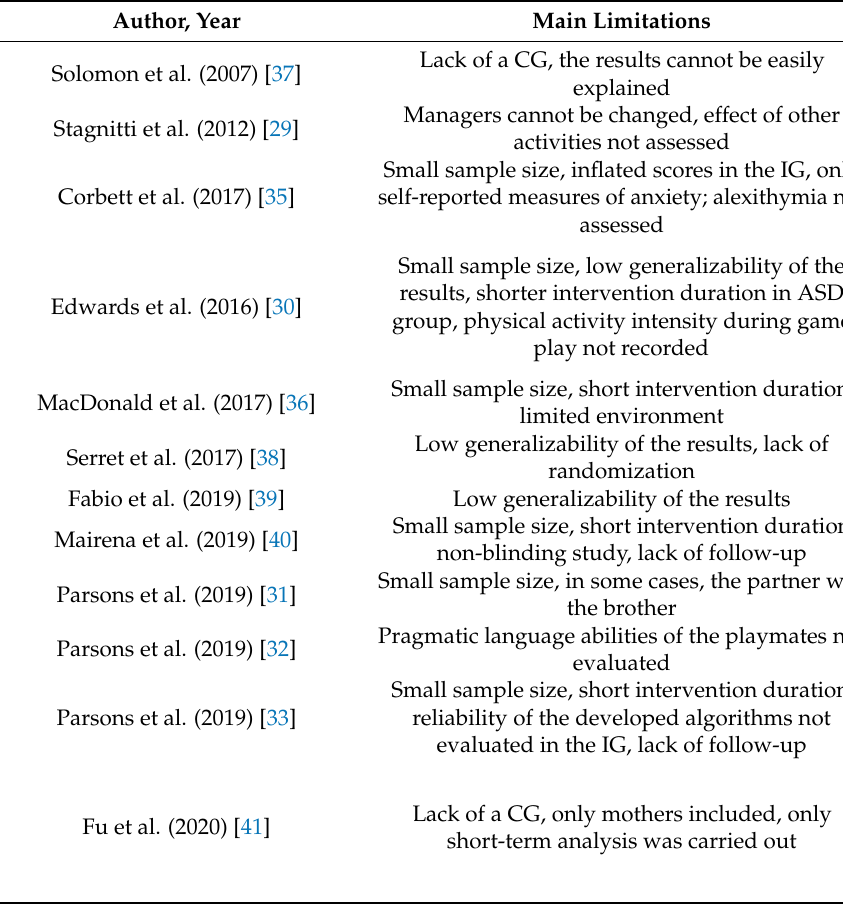
Table 4. Items related to risk of bias of included